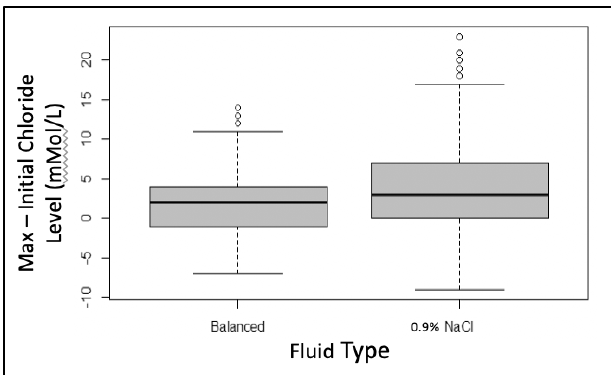
Figure 1. Comparison of the change in serum chloride level by subtracting the initial chloride level from the maximum chloride level in the first 72 h of admission. The 0.9% saline group had a significantly higher increase in chloride level compared to the balanced solution group, p < 0.005.